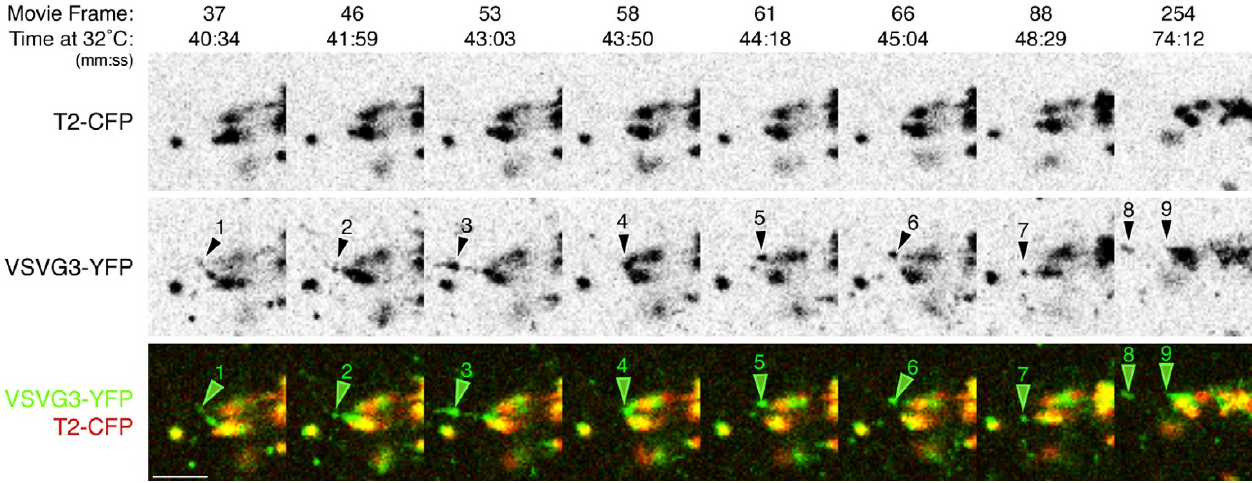
Figure 4 Cargo domains repeatedly shed post-Golgi carriers Transiently expressed VSVG3-YFP cargo was accumulated in the ER and pulsed into the secretory pathway of PtK 2 cells as in Figure 1B. Time at 32 ° C and the frame number of the correspond- ing movie (Additional Fileset 4 are indicated. Cargo domains develop on Golgi elements and post-Golgi TCs repeatedly exit from these domains. discrete exit events are numbered. Event (4) shows coalescence of a large cargo domain prior to the exit event (5) . During exit event (8) , the TC extends the domain as if the TC and domain were still connected (9) . It is especially apparent in the movie (Additional Fileset 4) that cargo domains and regions of Golgi elements move as if they were connected. Bar: 5 µ